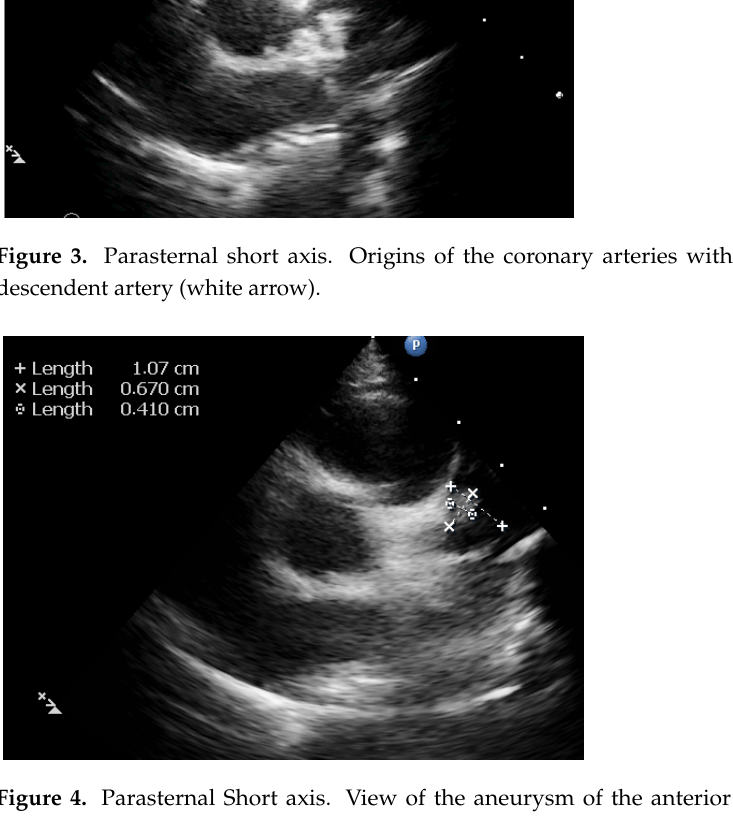
Figure 4. Parasternal Short axis. View of the aneurysm of the anterior descending artery with thrombus inside.